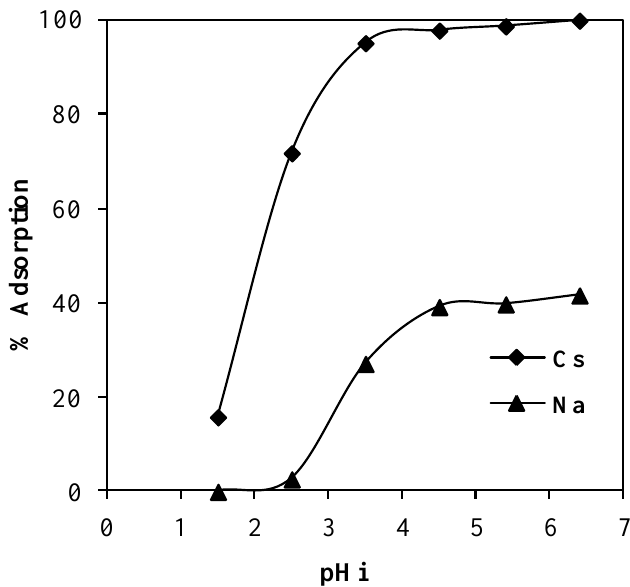
Figure 5. Percentage adsorption of cesium(I) and sodium(I) ions on crosslinked persimmon tannin (CPT) gel at varying initial pH [17] (with permission for reuse from Elsevier B.V.).